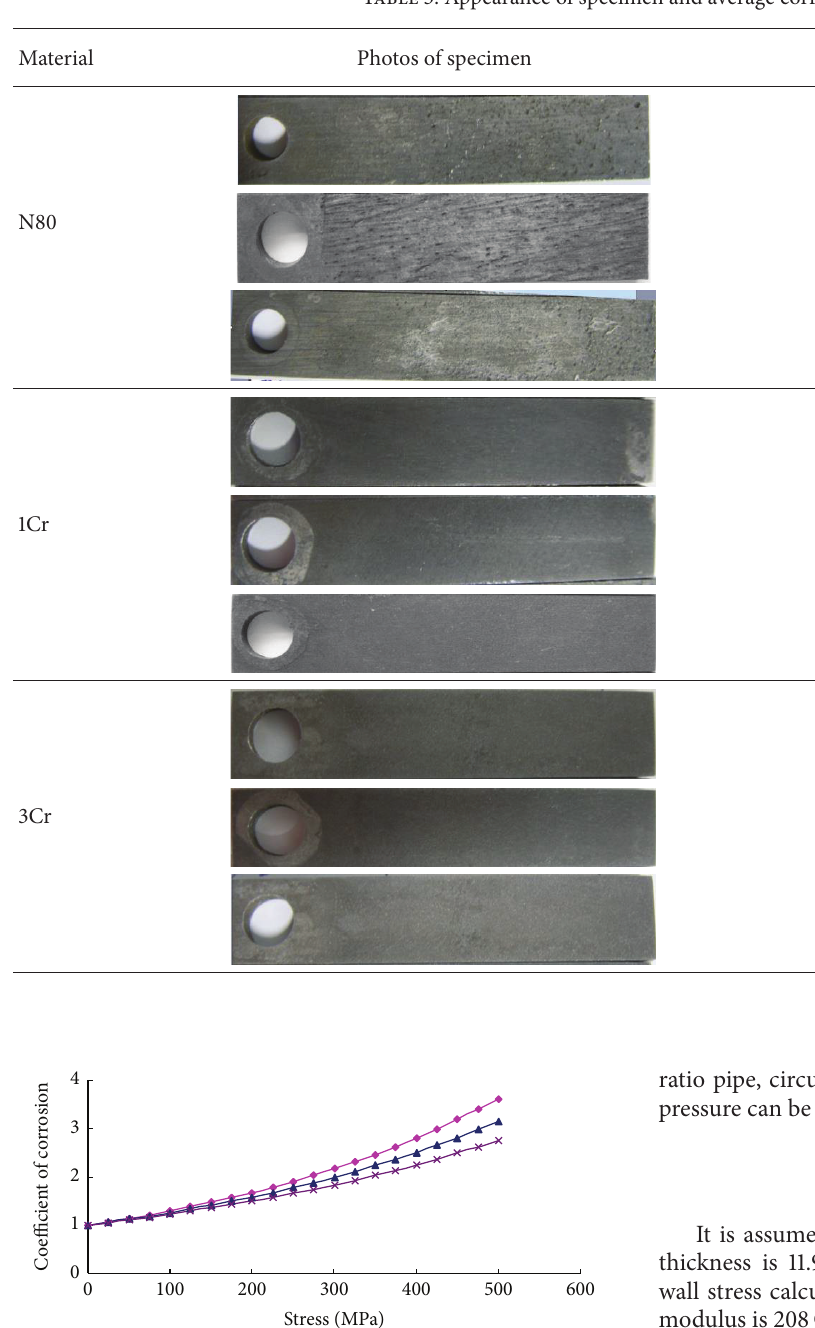
Table 3: Appearance of specimen and average corrosion rate.